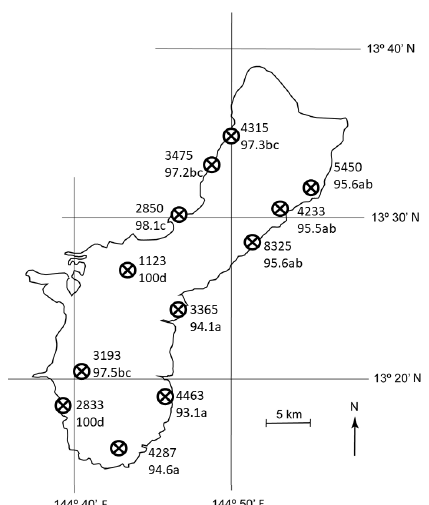
Figure 4. The number of Cycas micronesica stems per ha among 12 Guam habitats from 2005 (upper number for each site) and the percent mortality between 2005 and 2020 (lower number for each site). Mortality means with same letter are not different according to Tukey’s honestly significant difference, n = 10.